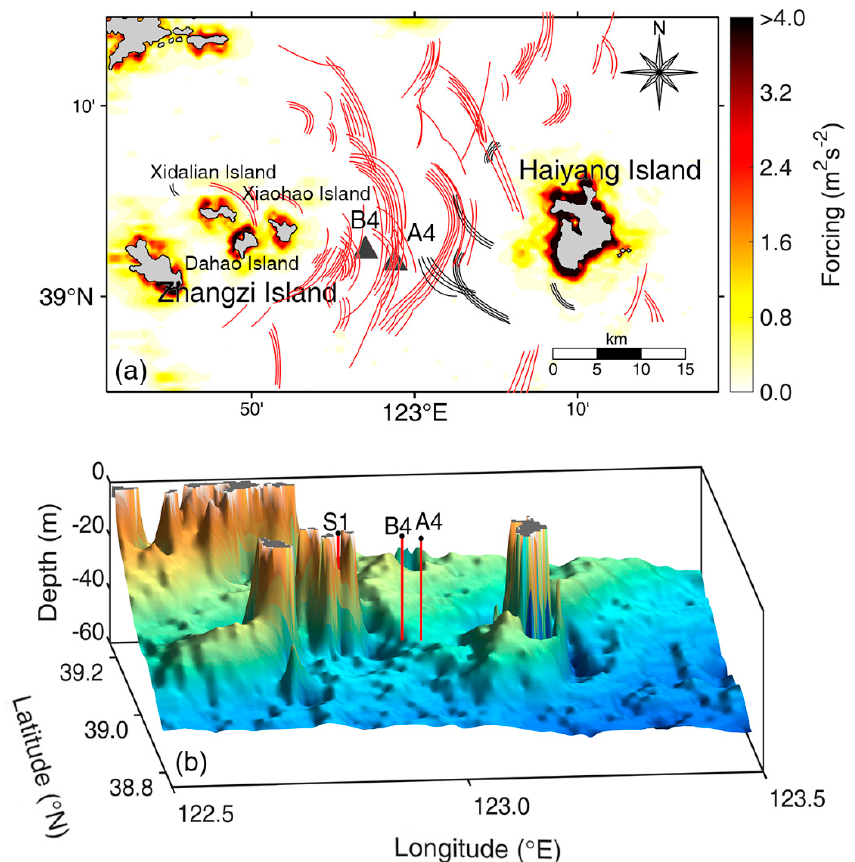
Figure 10. ( a ) The spatial distribution of the depth-integrated internal-tide-generating body force. The superposed curves represent the ISWs detected by SAR images during the observation periods of 2018 and 2019. ISWs propagating eastward and westward are shown in red and black, respectively. ( b ) The three-dimensional topography shows the surrounding study area. The ISW generation site, as traced by the ray-tracing method, is represented by S1. The locations of mooring stations are also indicated.